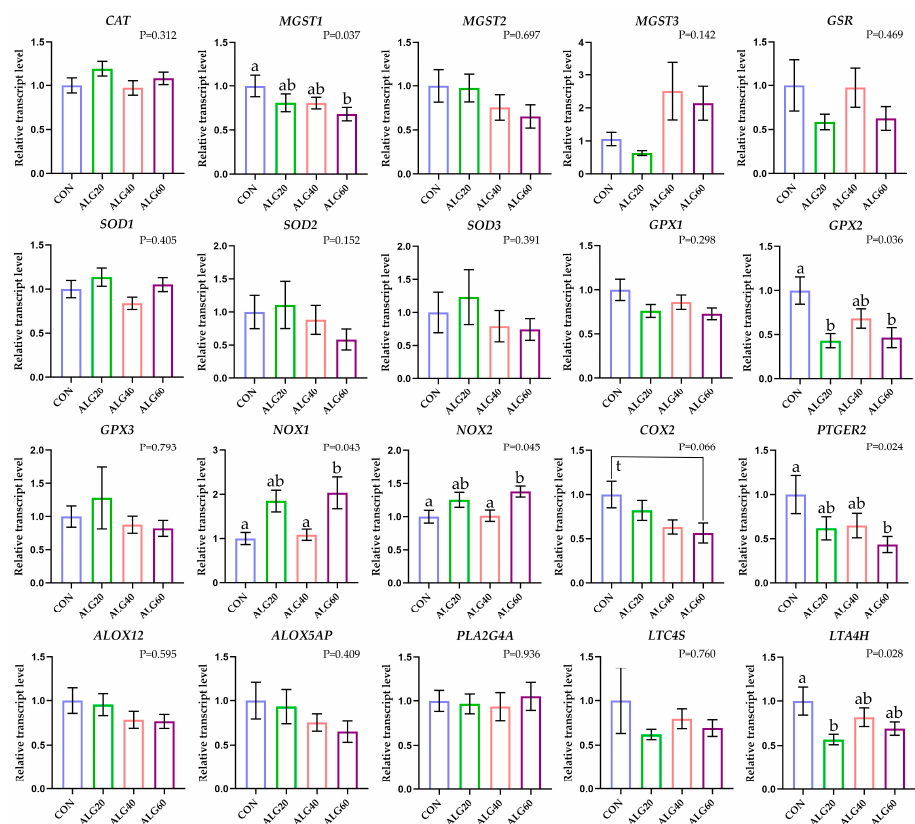
Figure 2. Mean and standard error (SE) of relative transcript levels as fold change of several anti- and pro-oxidant-related and immune-related gene expressions in neutrophils of goats fed the four experimental diets (CON, ALG20, ALG40, and ALG60) at three sampling times (20th, 40th and 60th). Different superscript (a, b) between dietary treatments differ significantly ( p ≤ 0.05) while, t; trend refers to p < 0.10.